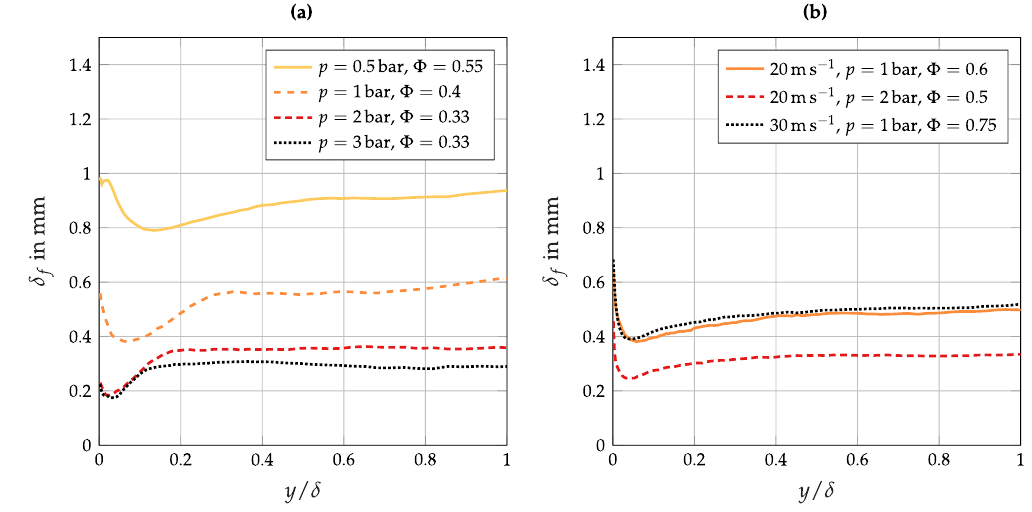
Figure 7. Flame thickness profiles at flashback conditions for ( a ) U b = 10ms − 1 and for ( b ) U b = 20ms − 1 and U b = 30ms − 1 .